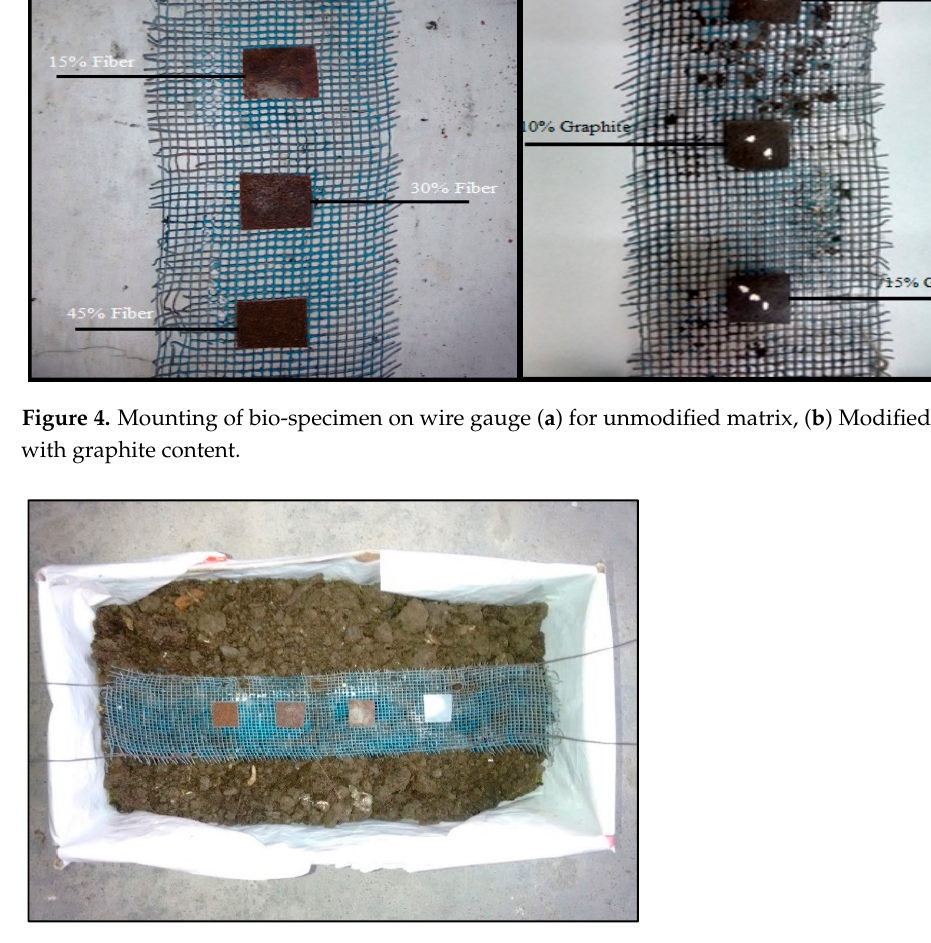
Figure 5. Compost box with samples placed inside.